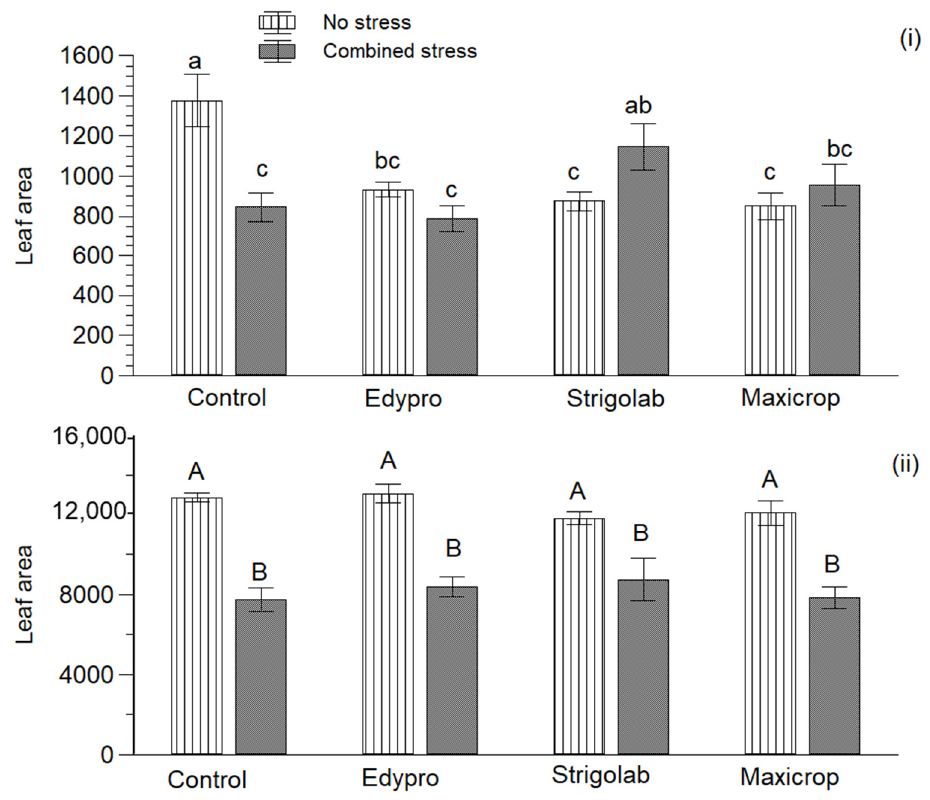
Figure 5. Effects of combined water and nutrient stress and biostimulant application (Control: No biostimulant applied, Edypro: application of COUPÉ REGENERACIÓN and PROCUAJE RADIC- ULAR, strigolactone-based biostimulant, and Maxicrop) on tomato leaf area (cm 2 ) ( i ) 70 days after transplanting, and ( ii ) at the end of the cultivation period. Means ( n = 4) followed by different letters indicate significant differences according to Duncan’s multiple range test ( p < 0.05).